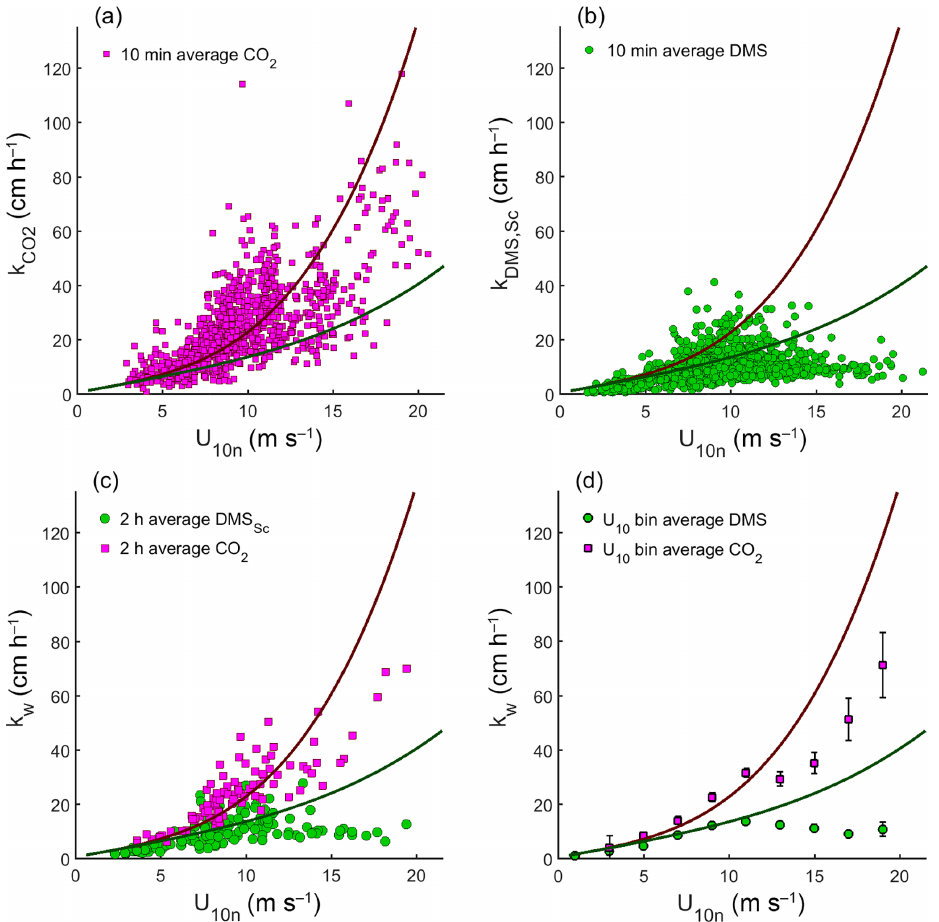
Figure 5. Gas transfer velocities plotted against mean horizontal wind speed ( U 10 ) from the Knorr_11 cruise: 10min average data for CO 2 (a) and DMS (b) . DMS gas transfer velocities are normalised to the in situ CO 2 Sc number . Data are averaged into 2h periods (c) and 2ms − 1 wind speed bins (d) . Note that negative k CO2 data in (a ) have not been plotted for clarity (see Fig. S8 for full data set). For reference, the NOAA COAREG3.1 model output for CO 2 (magenta line) and DMS (green line) is plotted on all four panels. The COARE model was run with the turbulent/molecular coefficient, A = 1.6, and the bubble-mediated coefficient, B = 1.8, and used mean Knorr_11 data for the input